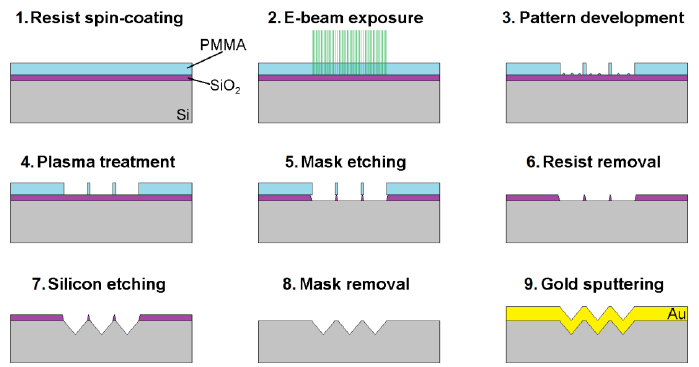
Figure 1. Schematic description of the process for SERS (Surface-enhanced Raman spectroscopy) substrate preparation. See detailed description of the process in the main text.